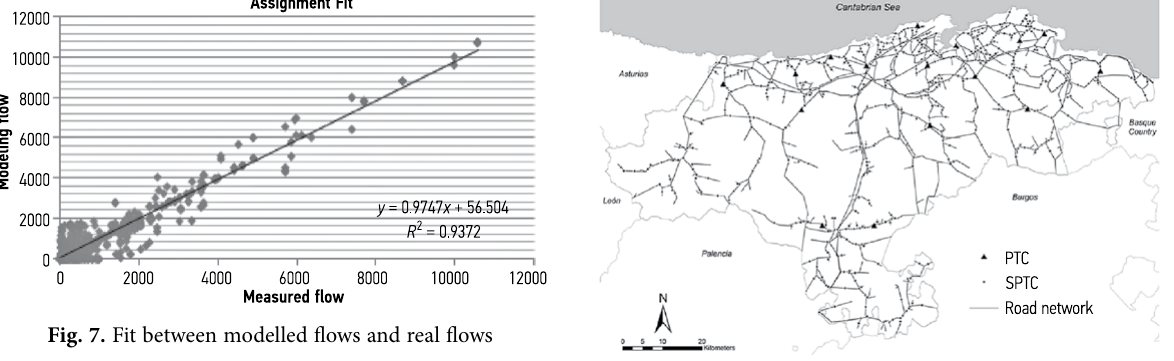
Fig. 8. Actual location of counting stations